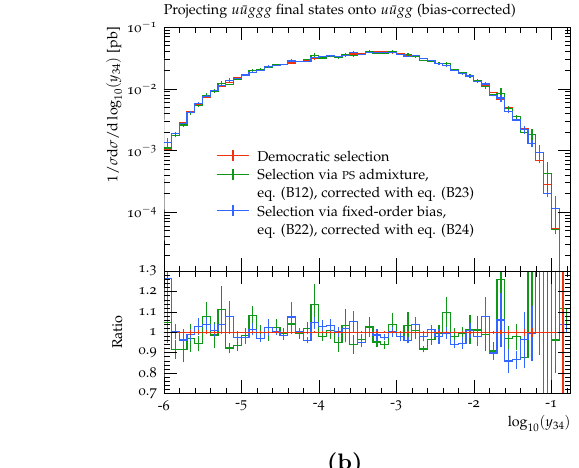
factors to map 2